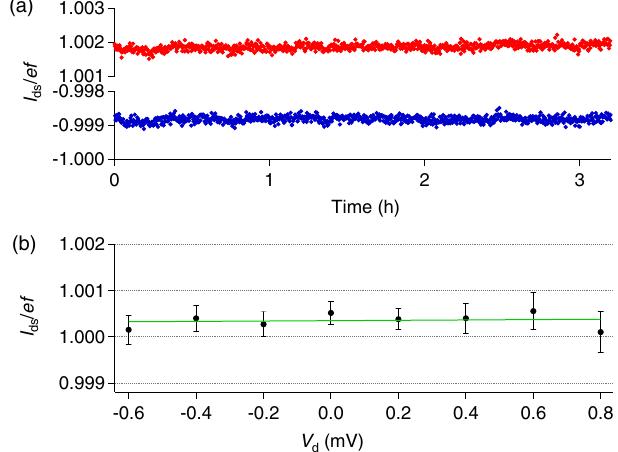
FIG. 5. (a) Alternating pumping experiment performed in sam- ¼ 0 mV . The dephasing is ple s 2 at 0.5 K, 650 MHz, and for V d periodically set to 171 (cid:4) and 189 (cid:4) , in order to pump, respectively, þ 1 (red circles) and (cid:2) 1 electron (blue circles) per cycle. This sequence is repeated over several hours. (b) Average values for þ and (cid:2) ef pumping obtained from data similar to (a) but in . The error bars are twice the 10 min only and for several V d statistical standard deviation. This data set yields a value of =ef ¼ 1 : 000 36 , well within the uncertainty of the measure- I ds ment setup, and sets a lower limit of 6 : 8 (cid:1) 10 13 (cid:1) for the resistance (standard deviation of the linear fit shown by the green